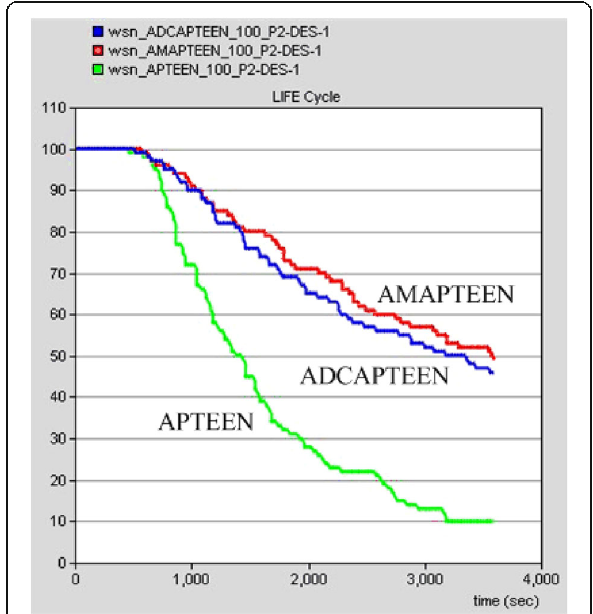
Fig. 15 The life cycle compared ADCAPTEEN with AMAPTEEN. This figure shows the comparison of network lifetime under ADCAPTEEN and AMAPTEEN. We can see that AMAPTEEN has further extended the network life cycle and improved the number of surviving nodes compared with ADCAPTEEN